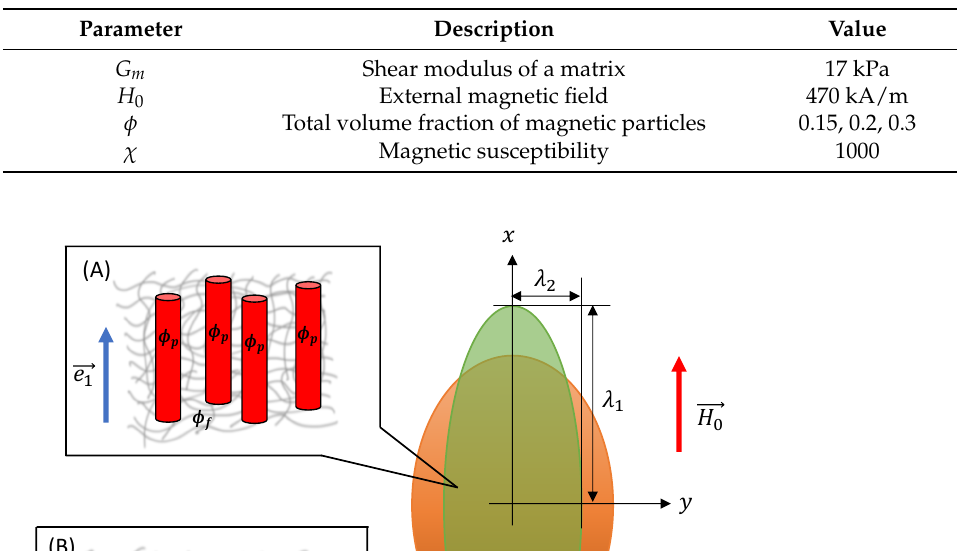
Table 1. The values of parameters used in the numerical calculations.